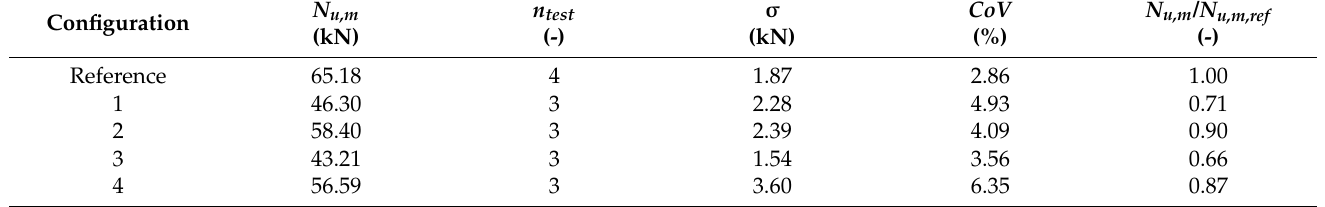
Table 7. Test results.